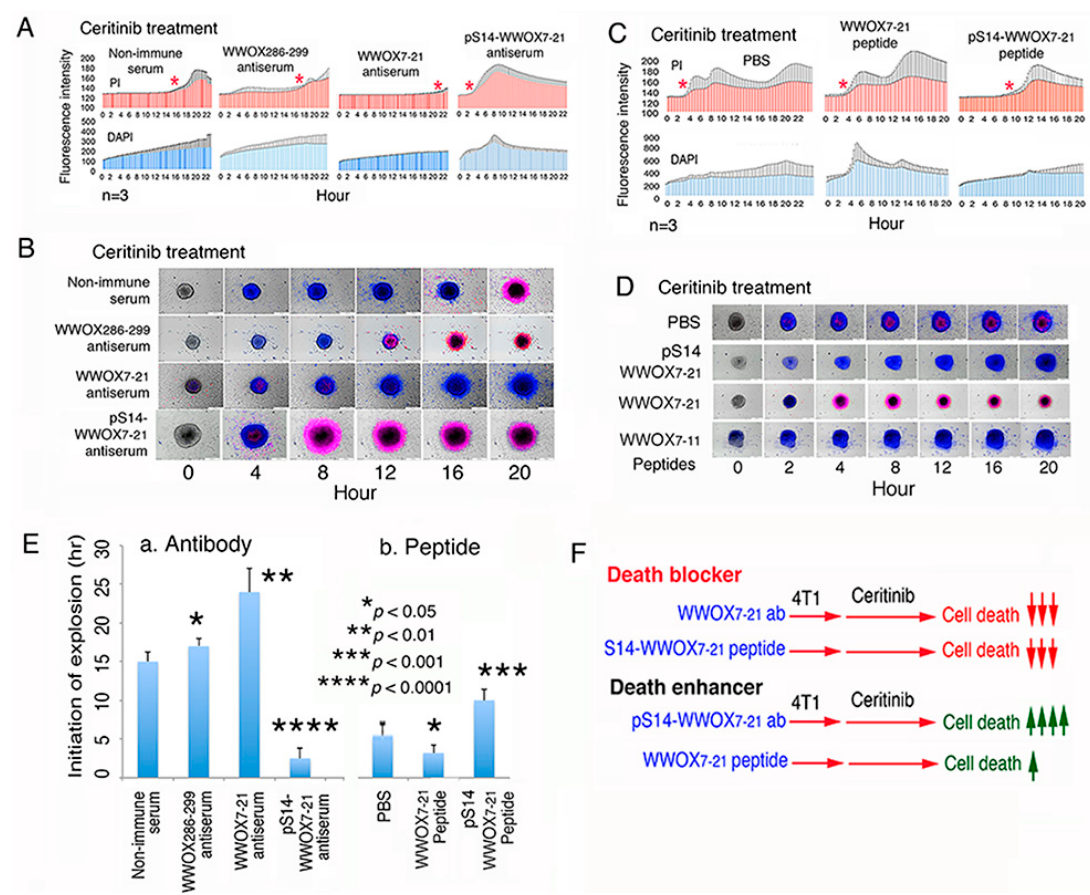
Figure 5. pS14-WWOX7-21 peptide blocked ceritinib-mediated 4T1 stem cell sphere explosion and death. ( A , B ) 4T1 stem cell spheres were treated with an indicated antiserum (1/100 dilution) for 30 min, and then exposed to ceritinib (30 µM) for time-lapse fluorescent microscopy at 37 °C. DAPI uptake in the nuclei (blue) by live cells indicates an increased nuclear membrane permeability, and PI uptake by nuclei (red) indicates cell death (mean ± SD; n = 3; SD in black shaded areas). The red stars show the initiation of stem cell sphere explosion and death. Representative changes in sphere morphology with time are shown. ( C , D ) pS14-WWOX7-21 peptide strongly blocked ceritinib-mediated cell death and sphere explosion; however, WWOX7-21 peptide drastically enhanced the cell death and sphere explosion event. ( E ) The time of initiation of 4T1 cell sphere explosion is shown ( n = 3). ( F ) Summary of enhancers and inhibitors for ceritinib-mediated cell death.